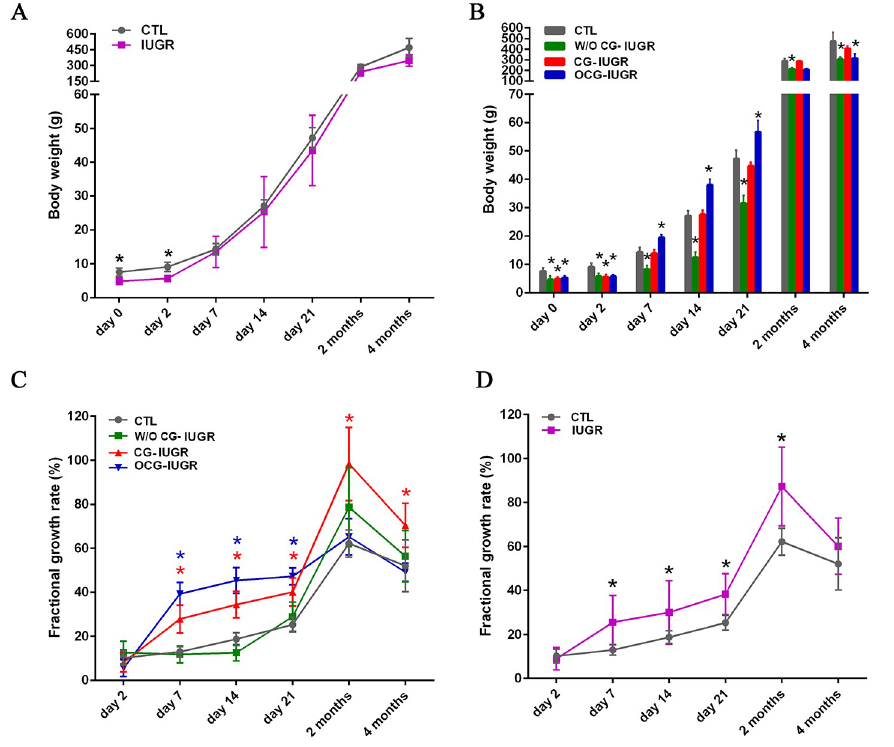
Fig 5. Catch-up growth occurs in the IUGR offsprings. A. Body weights of the controls (CTL) and the IUGR offsprings were recorded at birth (day 0), 2, 7, 14 and 21 days, as well as 2 and 4 months of age. Data are shown as mean ± SD . n = 45; � p < 0 . 05 vs . CTL . B. Based on the mean and standard deviations of body weights, IUGR offsprings were further identified as with catch-up growth (CG-IUGR), with over catch-up growth (OCG-IUGR), and without catch-up growth (W/O CG-IUGR). Data are shown as mean ± SD . n = 45 (CTL) , 15 (W/O CG-IUGR) , 18 (CG-IUGR) , and 12 (OCG-IUGR); � p < 0 . 05 vs . CTL . C. The fractional growth rate was plotted from day 2 to 4 months for the controls, W/O CG-IUGR, CG-IUGR and OCG-IUGR. Data are shown as mean ± SD . n = 45 (CTL) , 15 (W/O CG-IUGR) , 18 (CG-IUGR) , and 12 (OCG-IUGR); � p < 0 . 05 vs . CTL . D. The fractional growth rate was plotted from day 2 to 4 months for the controls and the whole IUGR offsprings. Data are shown as mean ± SD . n = 45; � p < 0 . 05 vs . CTL